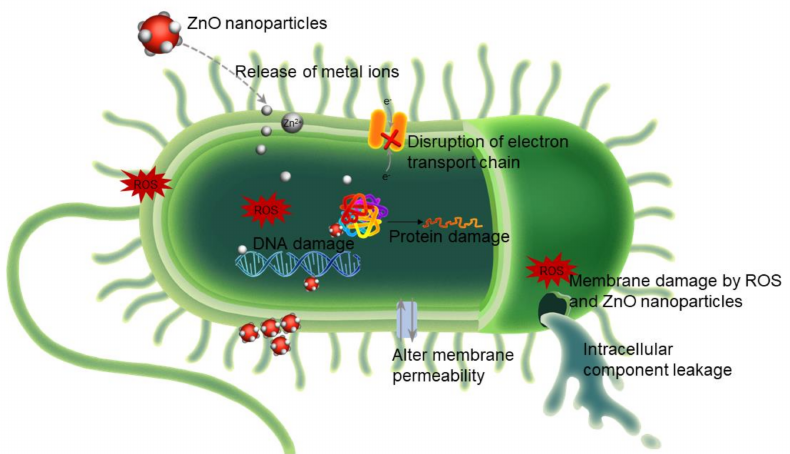
Figure 2. Schematic representation of probable mechanisms involved in ZnO antimicrobial activity. (i) The generation of reactive oxygen species (ROS), (ii) release of Zn 2+ ions, and (iii) alteration of bacterial membrane